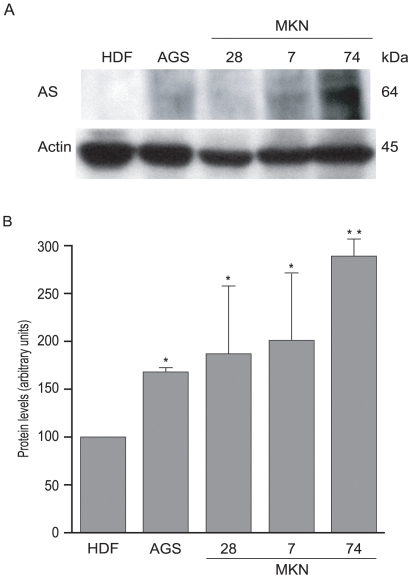
Expression of asparagine synthetase in cultured cell lines.(A) Western blot analysis of HDF, AGS, MKN28, MKN7 and MKN74 cell lysates for asparagine synthetase (AS). Actin was determined as loading control. (B) Densitometric analysis of protein levels normalized to the internal loading control. Results are expressed as a mean ± SD from 3 independent experiments *P≤0.05, **P≤0.01.